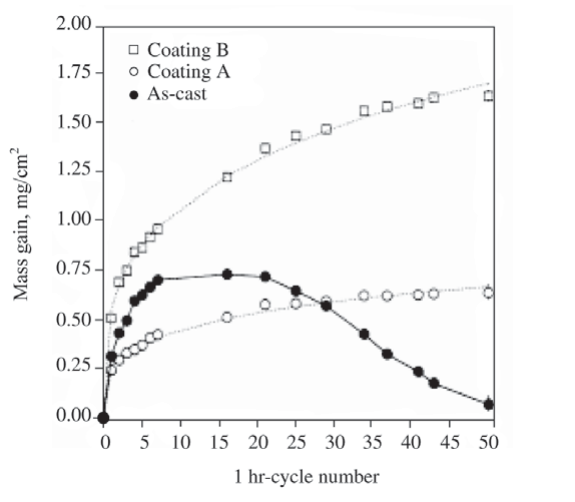
Figure 11 . A diagram showing the relationship of grain size, Al content, and oxidation products for Ni-20Cr-xAl at 1000 °C in air.